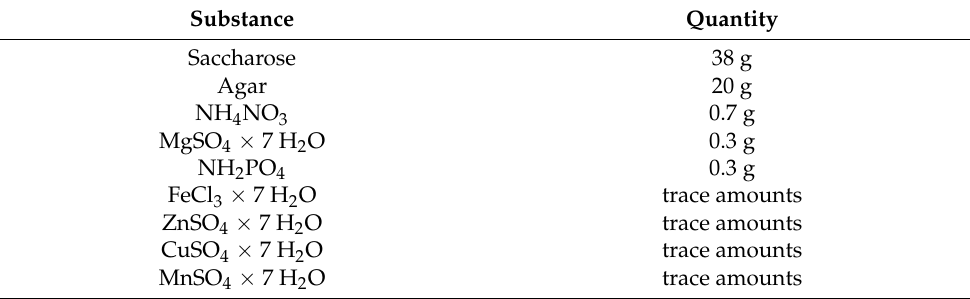
Table 2. Composition of mineral